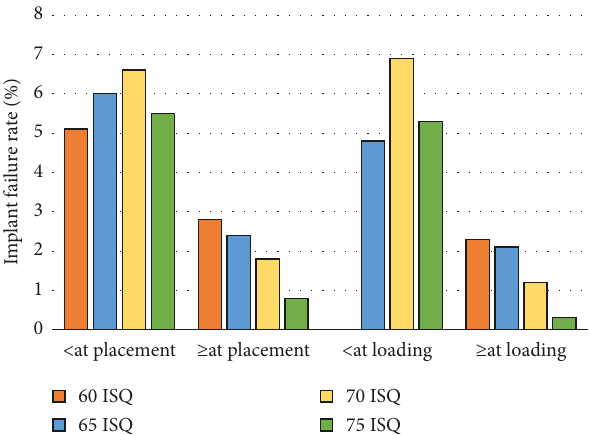
Figure 3: Failure rates for implants with values and 75ISQ at placement and loading. Note. There is a consistent correlation between failure and stability for implants above the threshold levels at placement and loading (see Table 10 for sta- tistical